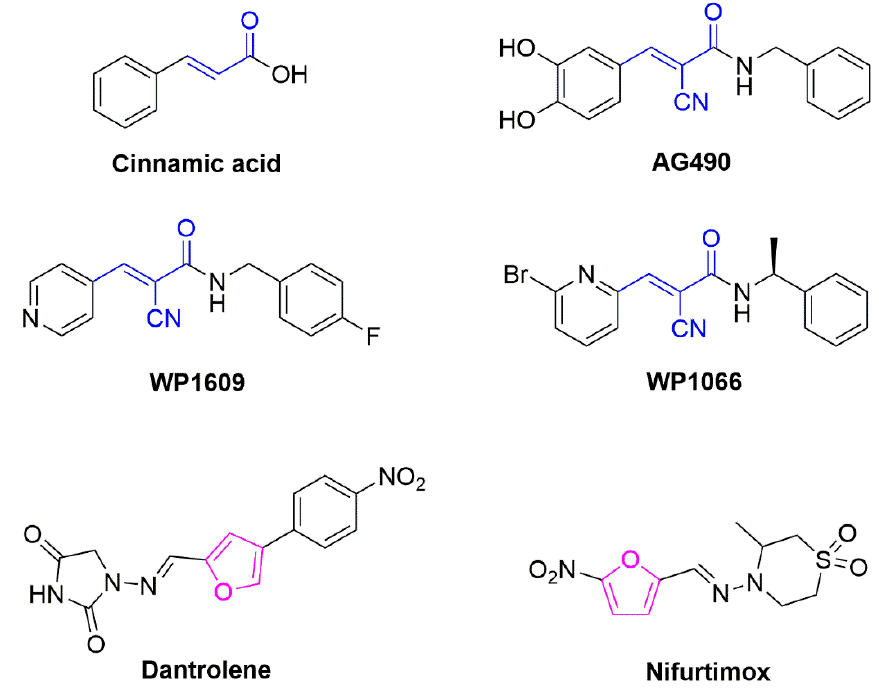
Figure 2. Structures of cinnamic acid benzyl amide derivatives and furan derivatives.